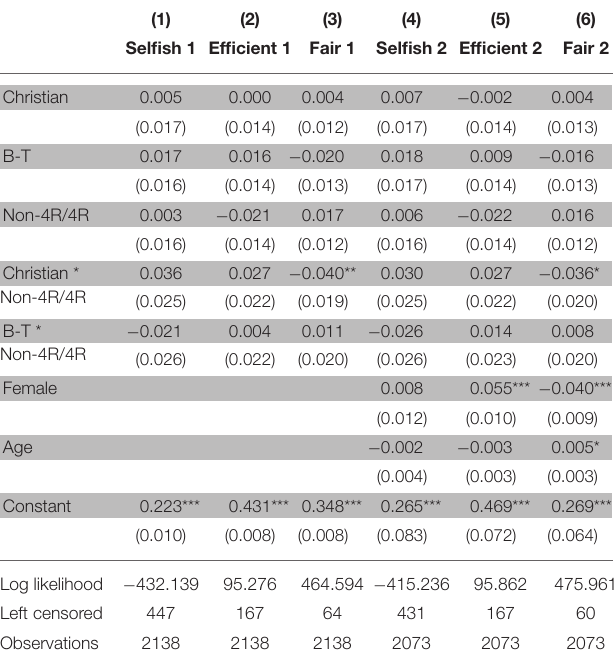
TABLE 2 | Tobit regression results for religion × DRD4